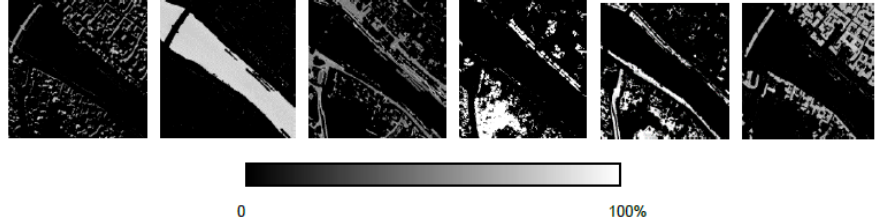
Figure 12. Proportion images of the seven classes obtained by spectral unmixing of the Data set 3: From left to right: shadow, water, road, tree, grass, and roof.